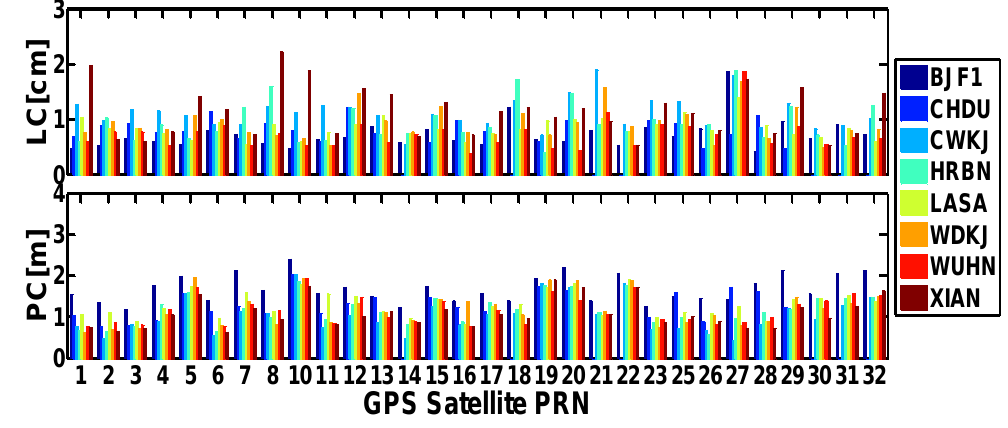
Figure 13. RMS values of the undifferenced LC and PC residuals for GPS satellites of all individual sites.